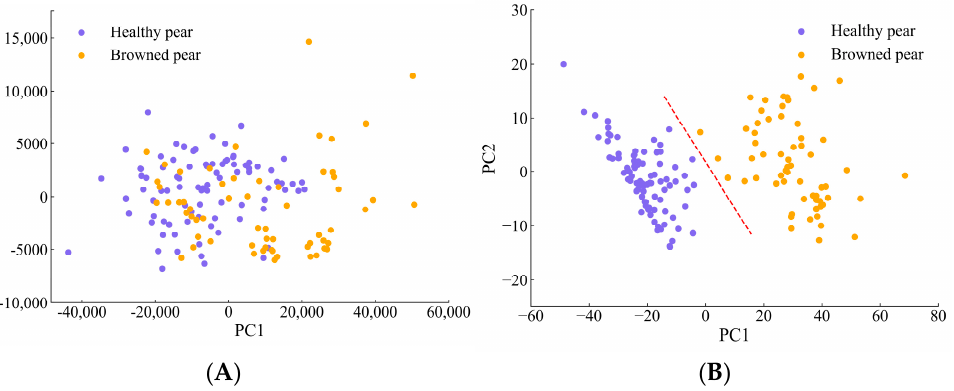
Figure 11. Two − dimensional spatial distribution of pear samples: ( A ) raw spectral data; ( B ) feature data extracted by 1D − CNN method.